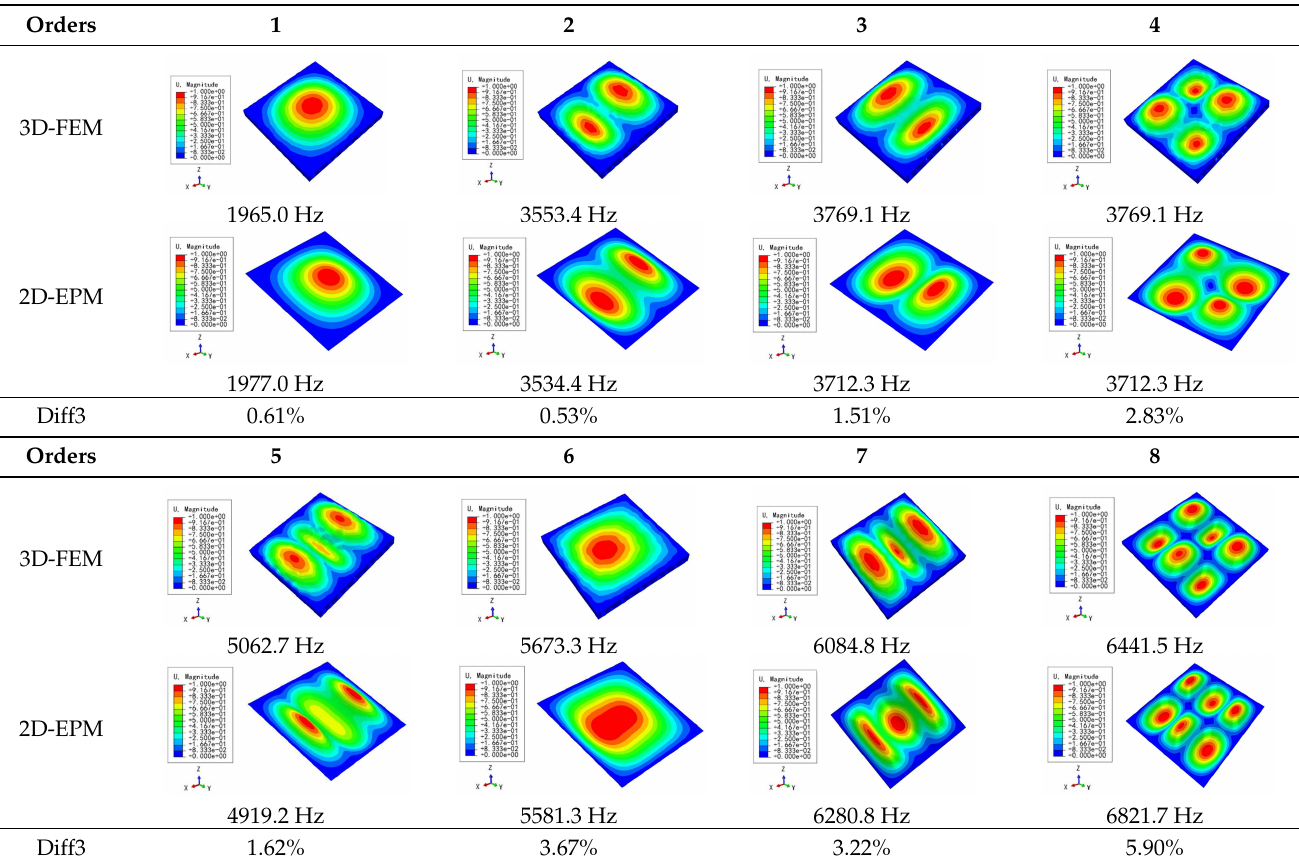
Table 6. Comparison of the higher-order vibration modes and the corresponding frequencies under CCCC boundary conditions predicted by different models.